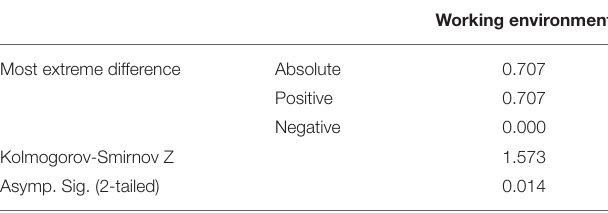
TABLE 6 | Kolmogorov–Smirnov test results of the index “working environment”.